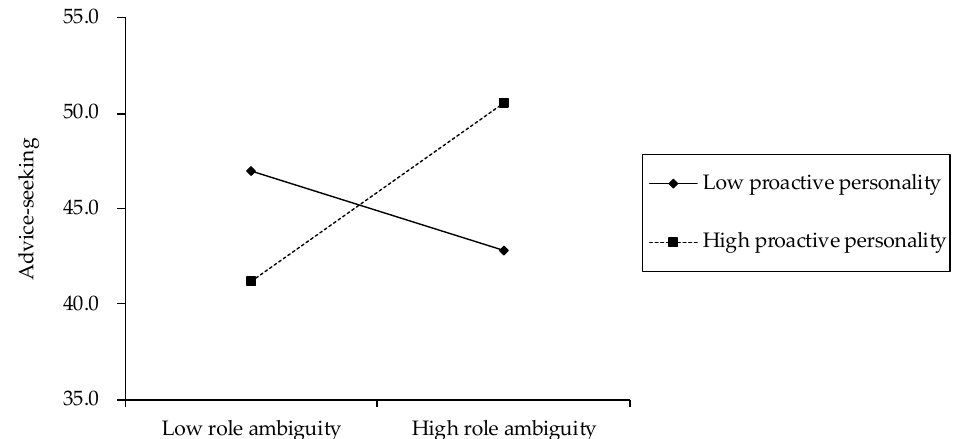
Figure 2. The moderating effect of proactive personality on the relationship between role ambiguity and advice-seeking.